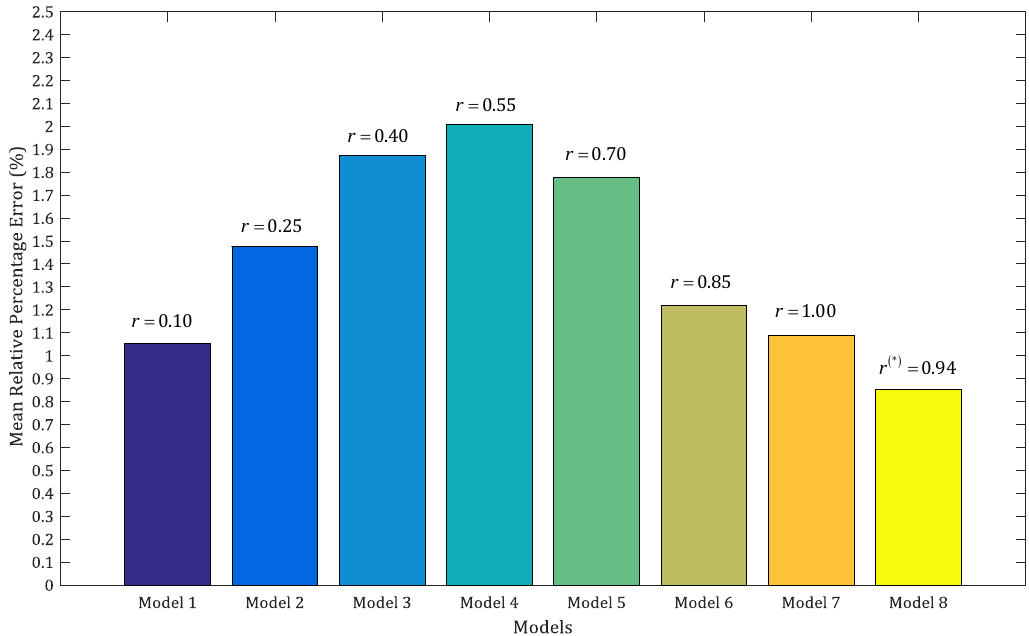
Figure 2. MRPEs of the DWSGM (1,1) model with different orders. MRPE: Mean Relative Percentage Error. Yellow: Model 8, r = 0.94, the optimal order; dark yellow: Model 7, r = 1; khaki: Model 6, r = 0.85; green: Model 5, r = 0.70; light blue: Model 4, r = 0.55; blue: Model 3, r = 0.40; dark blue: Model 2, r = 0.25; ink blue: Model 1, r = 0.10. The superscript symbol “*” stands for the optimal order.